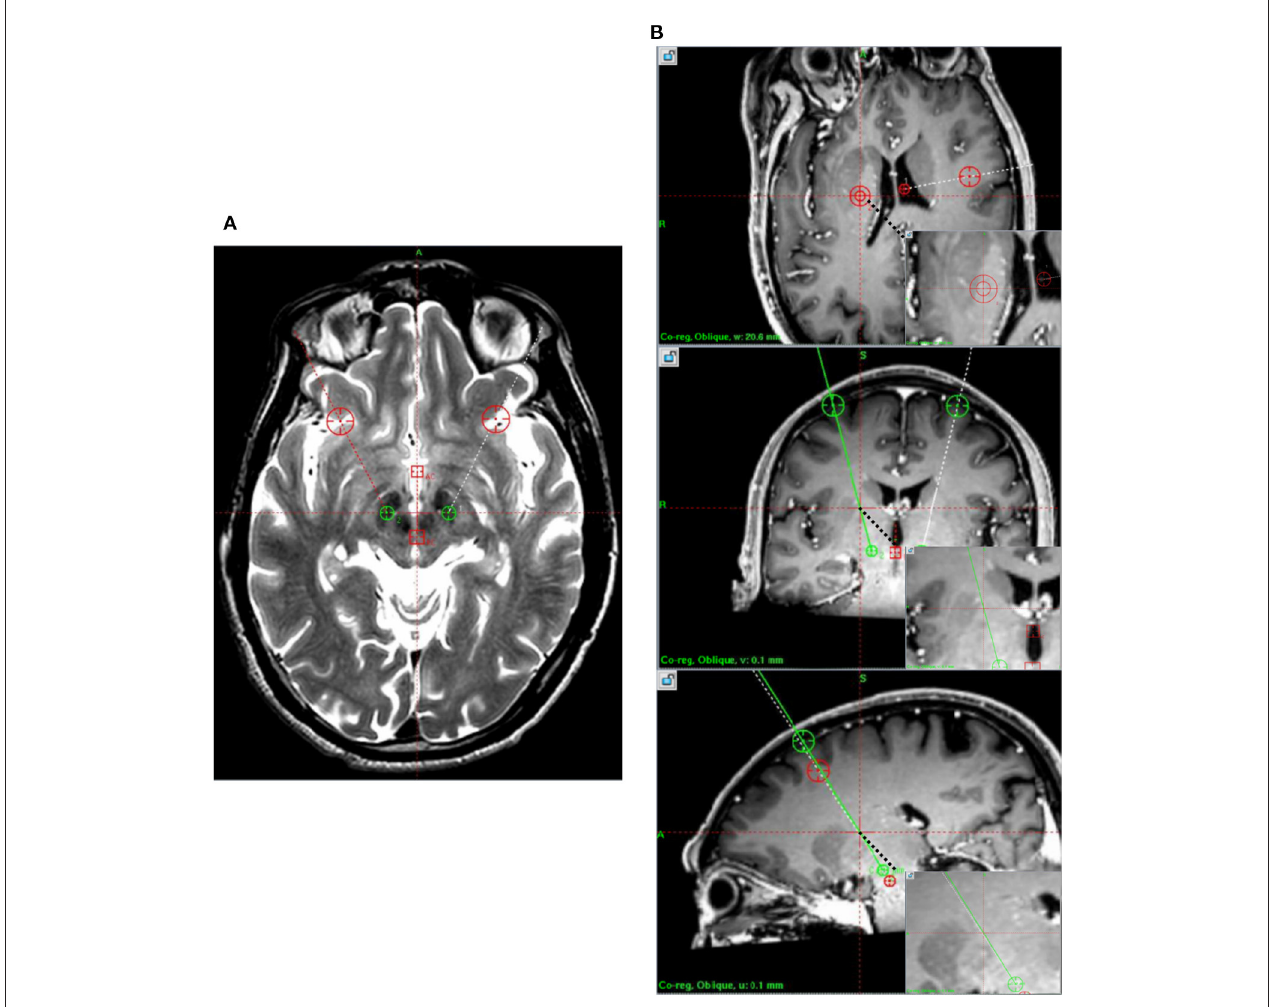
FIGURE 1 | Preoperative magnetic resonance imaging. (A) T2 images demonstrate the target. (B) T1 enhanced the discrimination of the blood vessels.